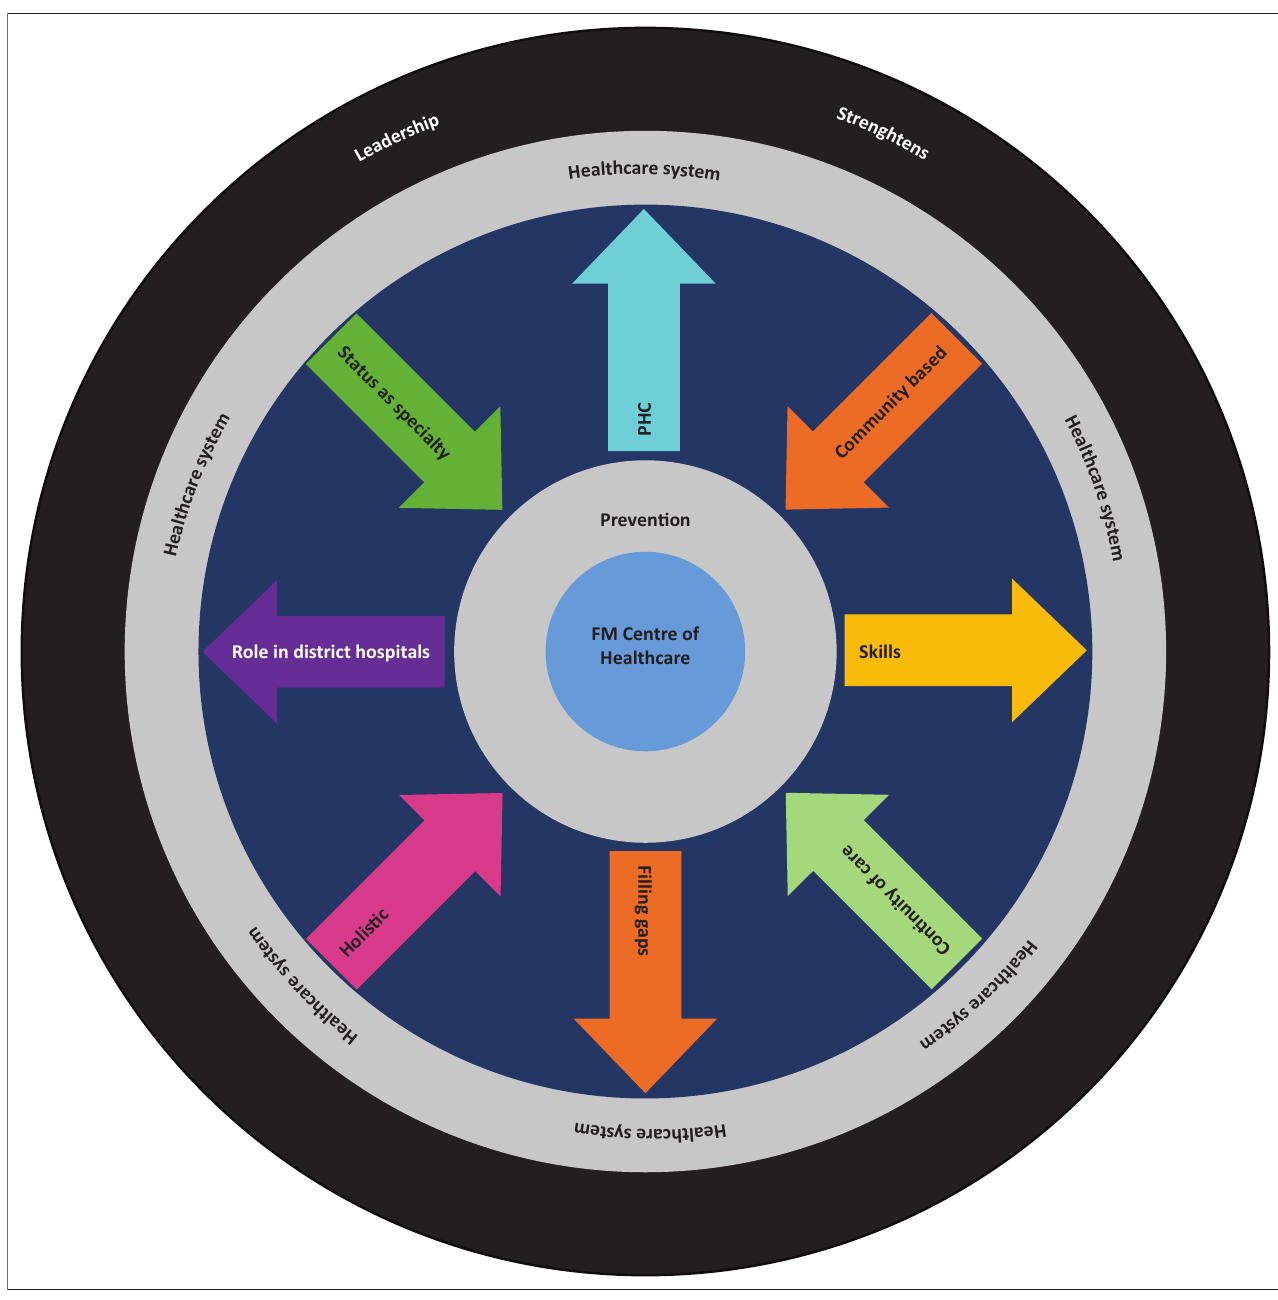
FIGURE 1: Model of family medicine as described by doctors at Letaba